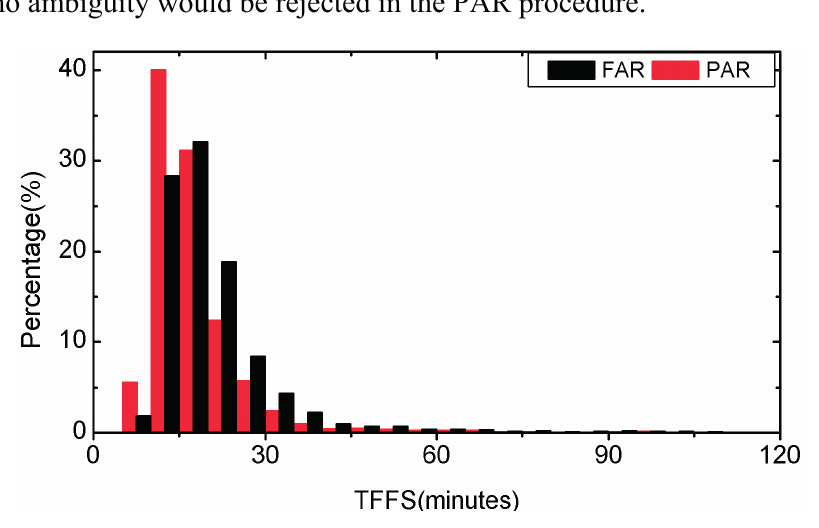
Figure 3. Distribution of TTFF of static PPP by employing FAR and PAR, respectively.